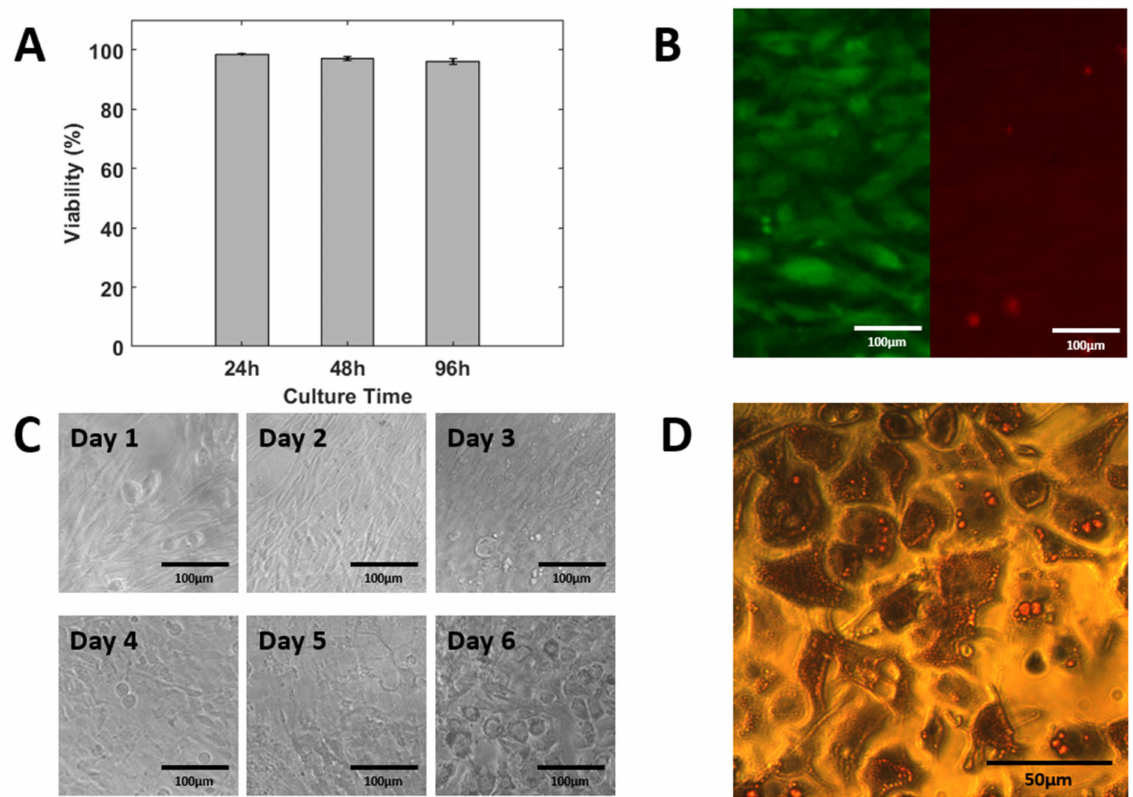
Figure 7. On-chip cell culturing and differentiation of 3T3 L1 cells to adipocytes. ( A ) Viability was assayed up to 96 h of culturing. ( B ) Live dead assay after 96 h culture. ( C ) On-chip differentiation can be seen up to Day 6. ( D ) Fat droplets were stained red and visualized under the microscope. This demonstrated the ability of our integrated pump to maintain long-term on-chip cell